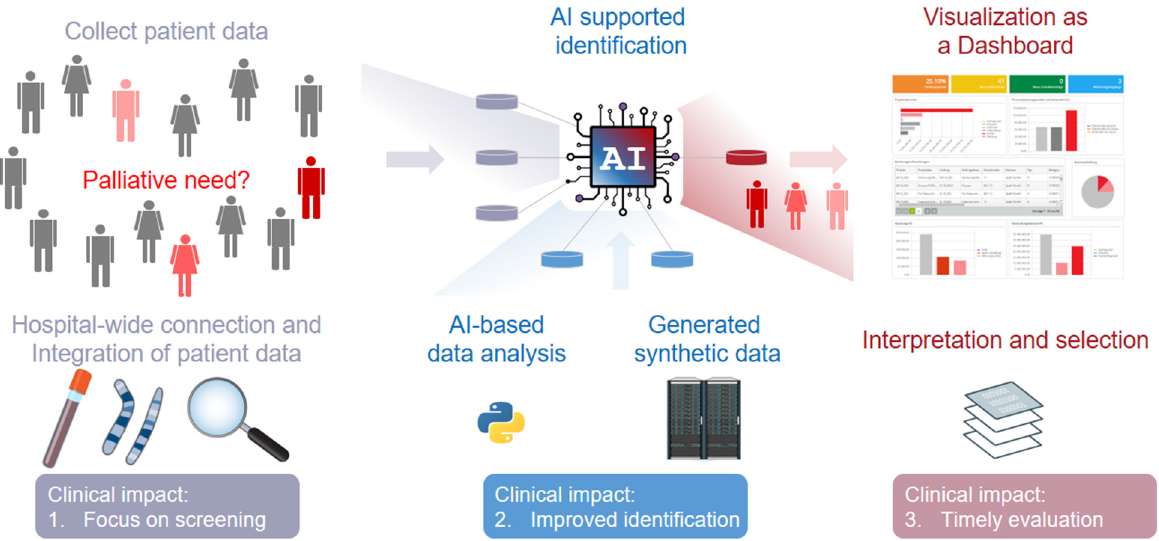
Figure 3. Scheme to illustrate the arising clinical impacts of synthetic data generation and Artificial Intelligence (AI) in general for palliative care. Such a concept would focus on patient screening and would use AI-based methods for an improved identification of patients, including a timelier screening (represented as different shades of red for the patients).